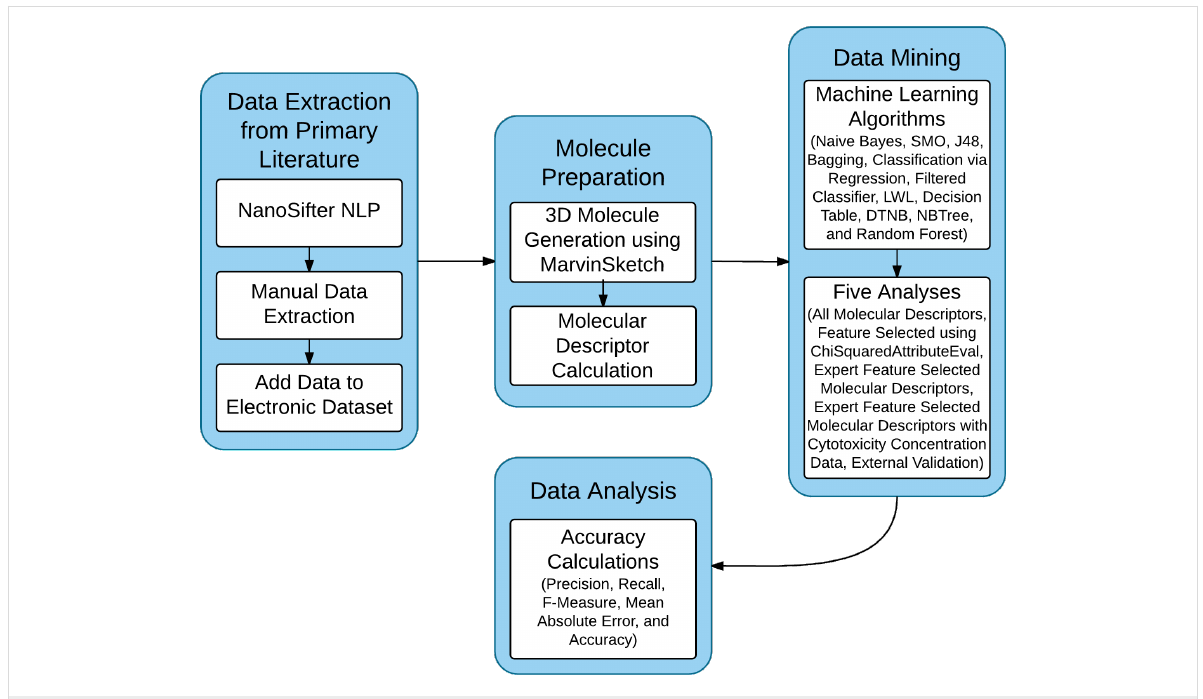
Figure 3: Simplified workflow diagram for the method used in this